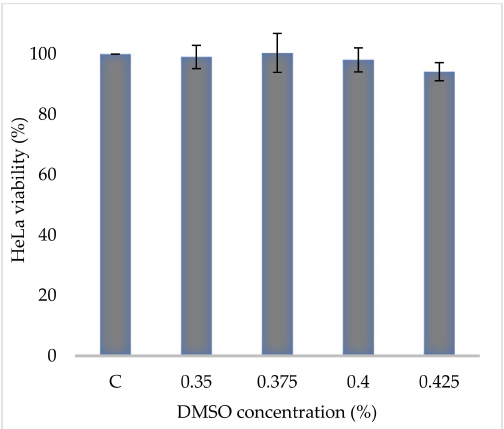
Figure 2. HeLa cells, control group (C = 100% viability) was not treated at all; experimental groups were treated with different concentrations (0.35, 0.375, 0.4, and 0.425 %) of DMSO for 24 h. The result did not show any significant difference. The data are shown as Mean ± SE. Mean significant difference compared to